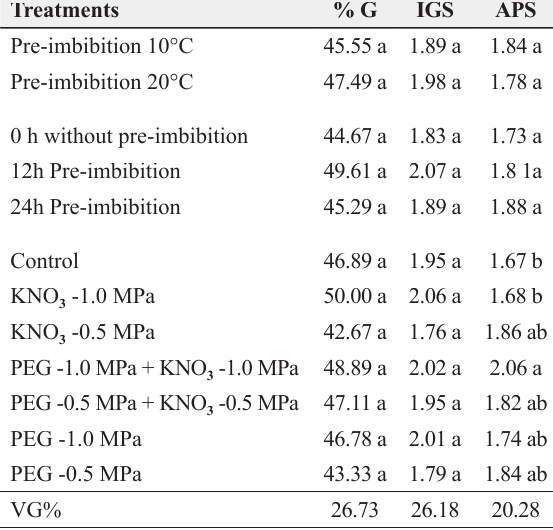
Means followed by the same letter in the columns do not differ themselves by Tukey test at 5% of